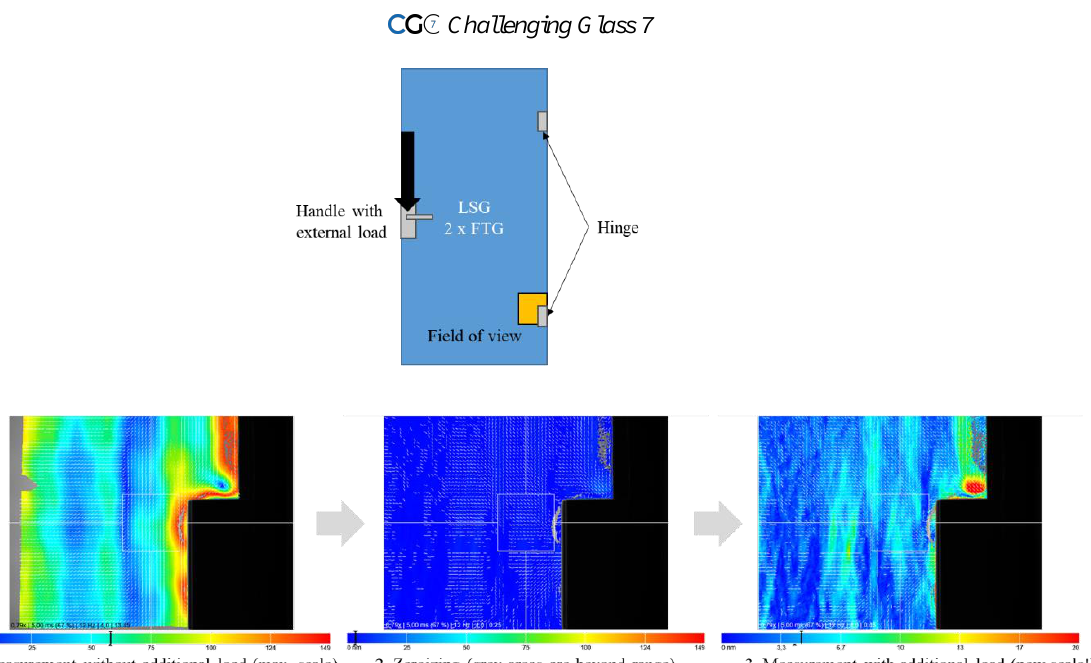
Fig. 13 Example of stepwise measurement of a tempered glass